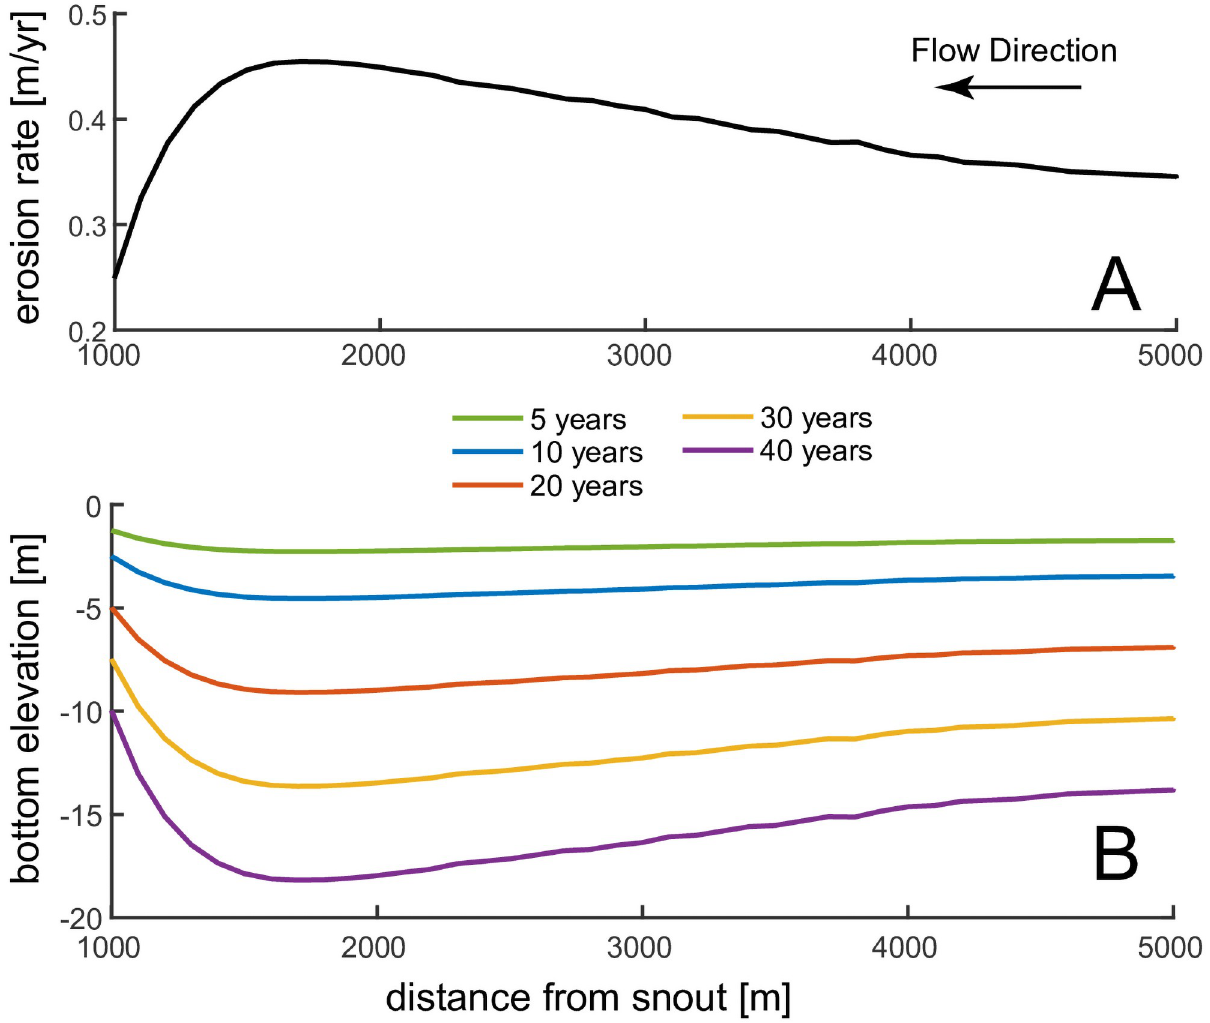
Fig 8. Evolution of a subglacial channel in time: A) erosion rate; B) bottom elevation. At the beginning of the simulations the channel has constant width (100m) and constant bottom elevation. Q = 20000 m 3 /s D s = 10cm q s = 40 kg/m/s.